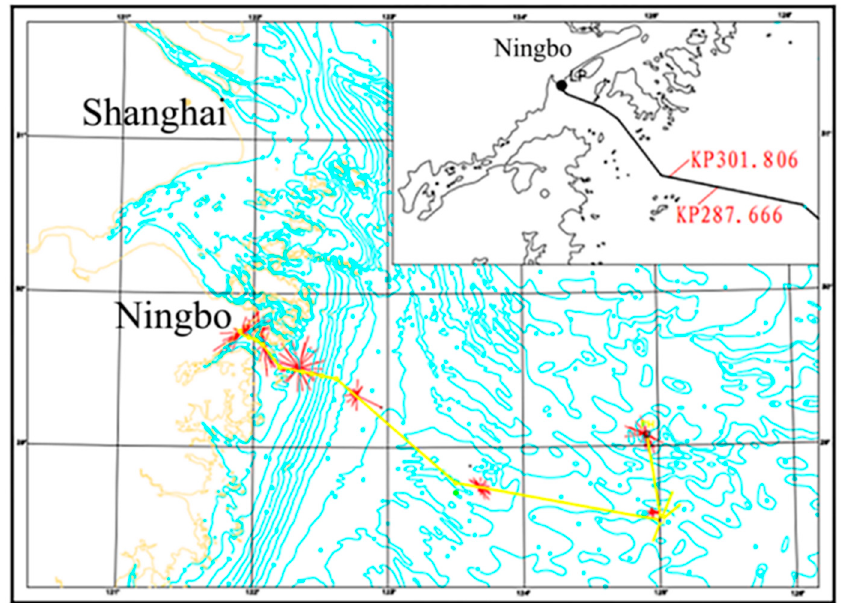
Figure 2. Location of Chunxiao Submarine Pipeline.